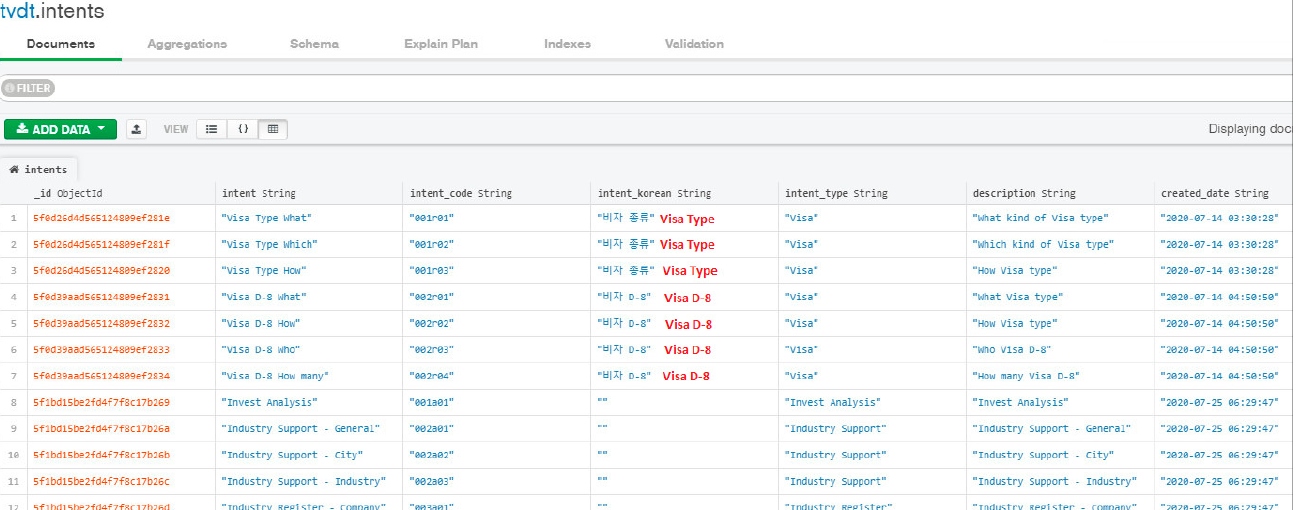
Figure 17. Intents’ dataset stored in MongoDB.